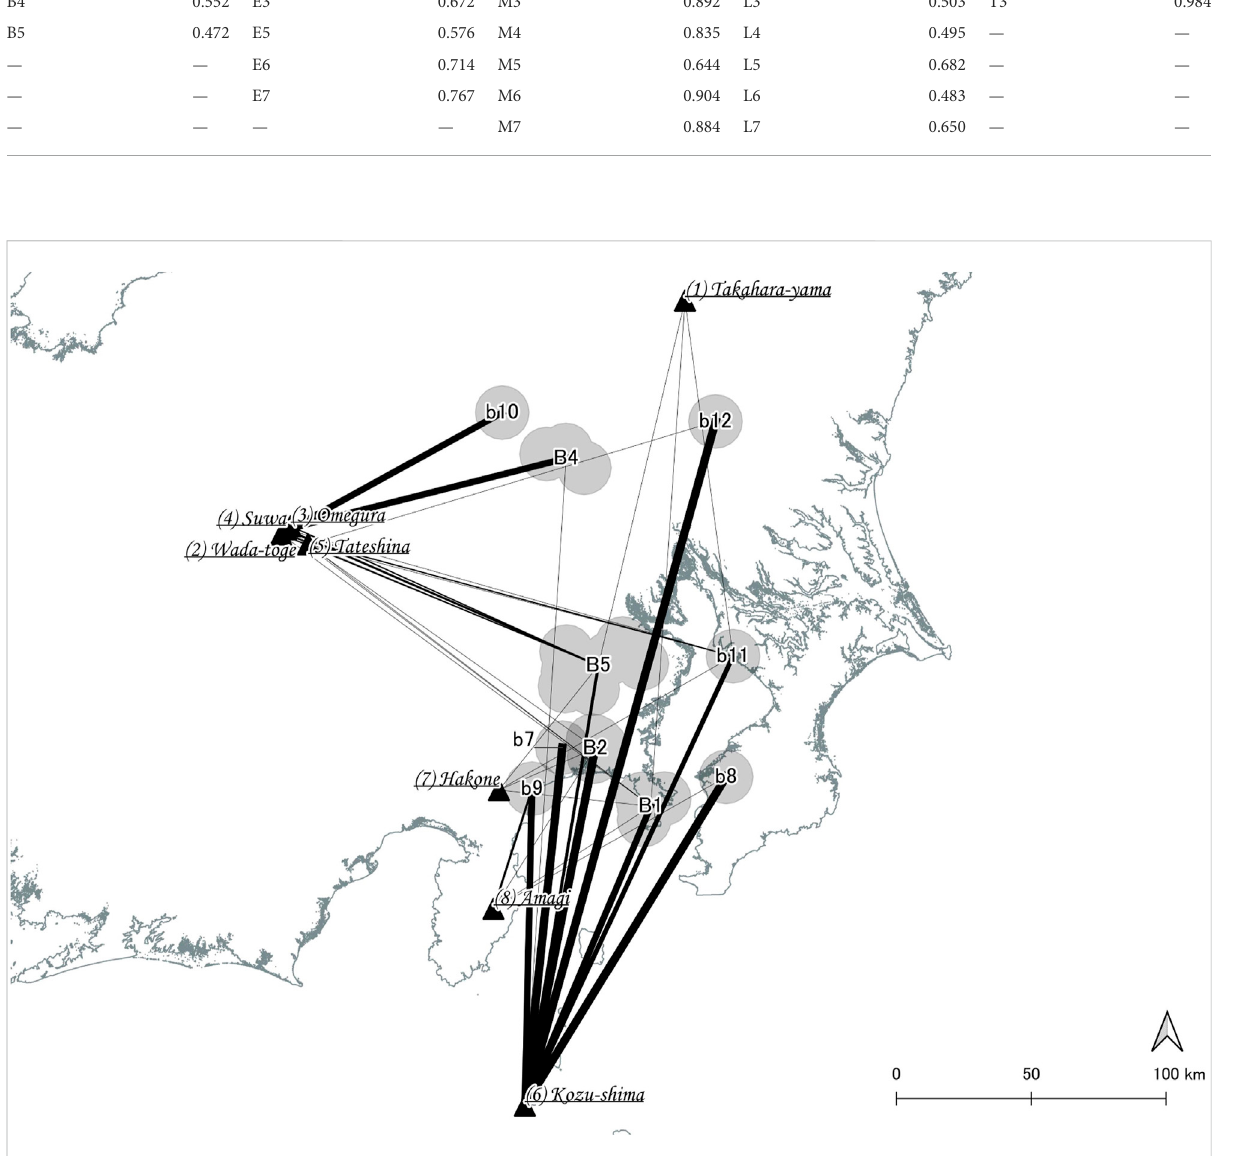
FIGURE 3 Bipartite graphs between provenance and consumption areas in Period 1, the beginning Jomon period, and the earlier Jomon period (16,000 – 7,000 years cal BP). Clusters are represented by uppercase characters and single sites by lowercase characters. The thickness of the links corresponds to the composition ratio of each production area in each cluster (B1, 2, 4, and 5) and each single site (b7 –